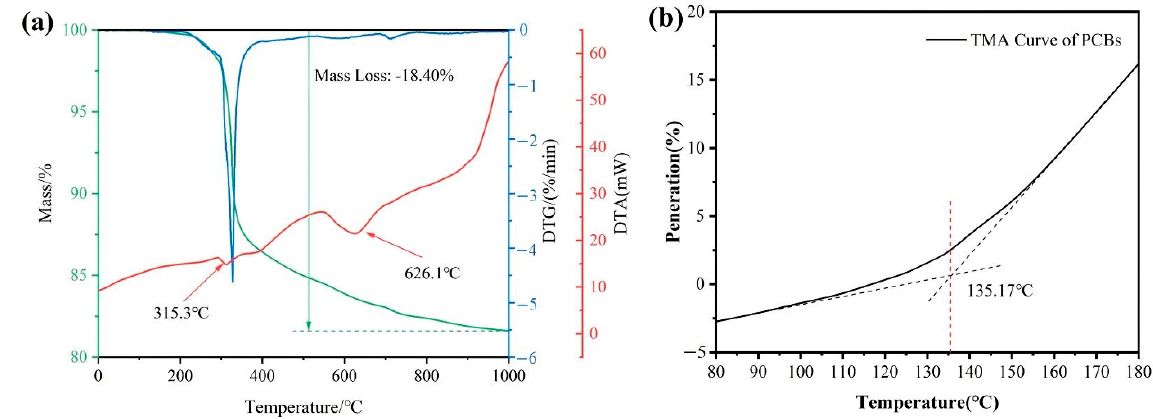
Figure 1. Characteristics of PCB after heat treatment. ( a ) TG-DTA curves of brominated epoxy resins in the PCBs. ( b ) TMA curve of brominated epoxy resins.